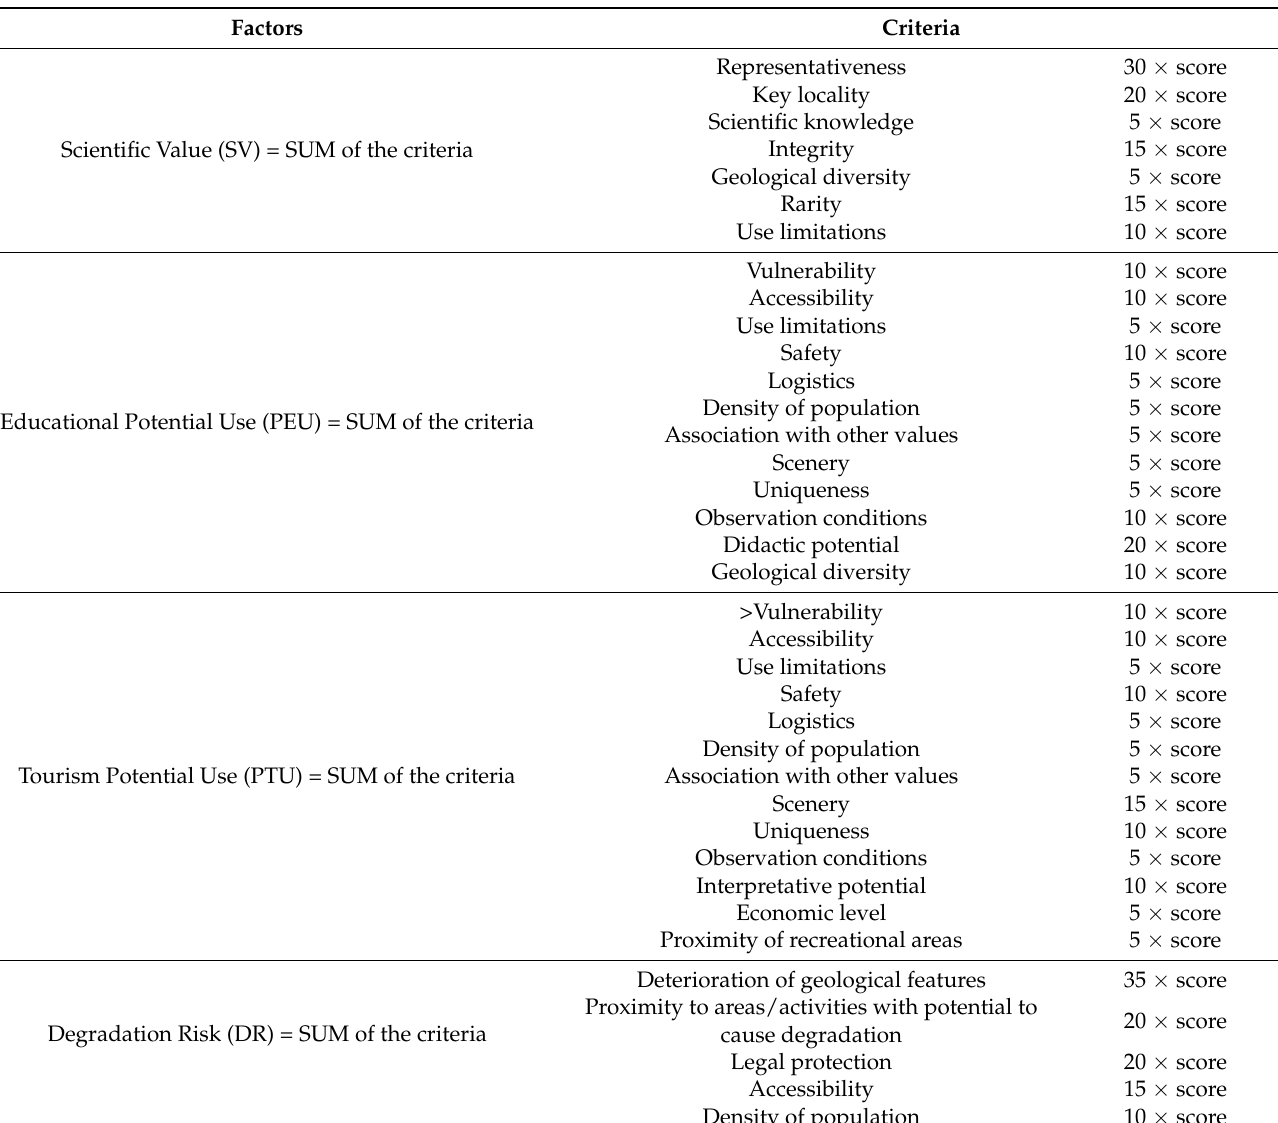
Table 1. Calculation of the final scores in the G-P